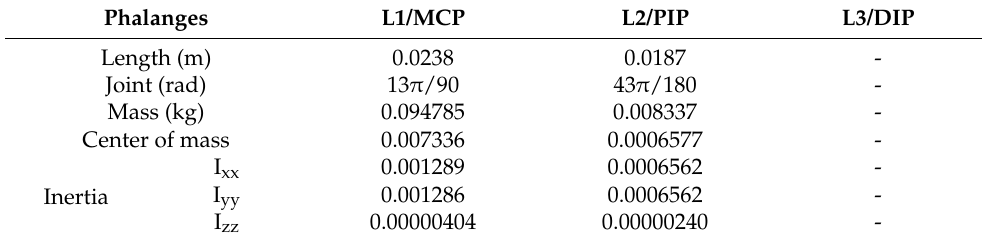
Table 5. Dynamic simulation parameters.